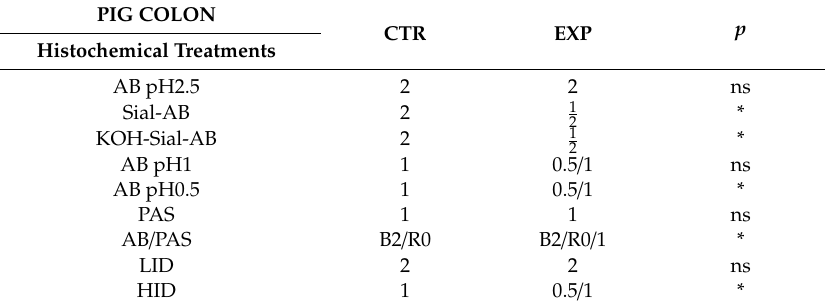
Table 3. Responses of pig colon goblet